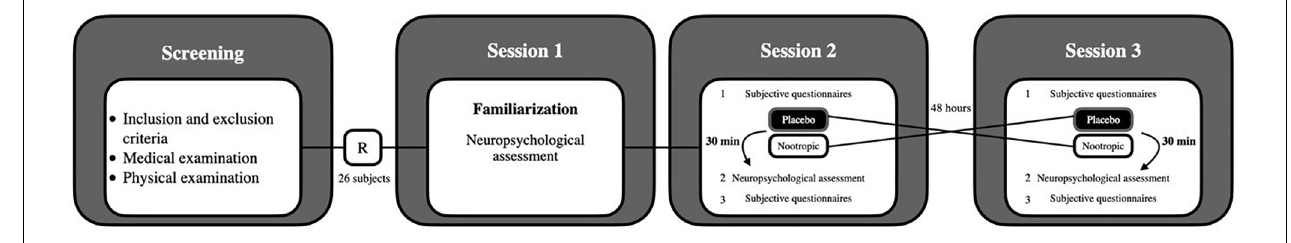
FIGURE 1 | Study design. After screening, 26 subjects were randomized (R) in a triple-blind, cross-over trial.